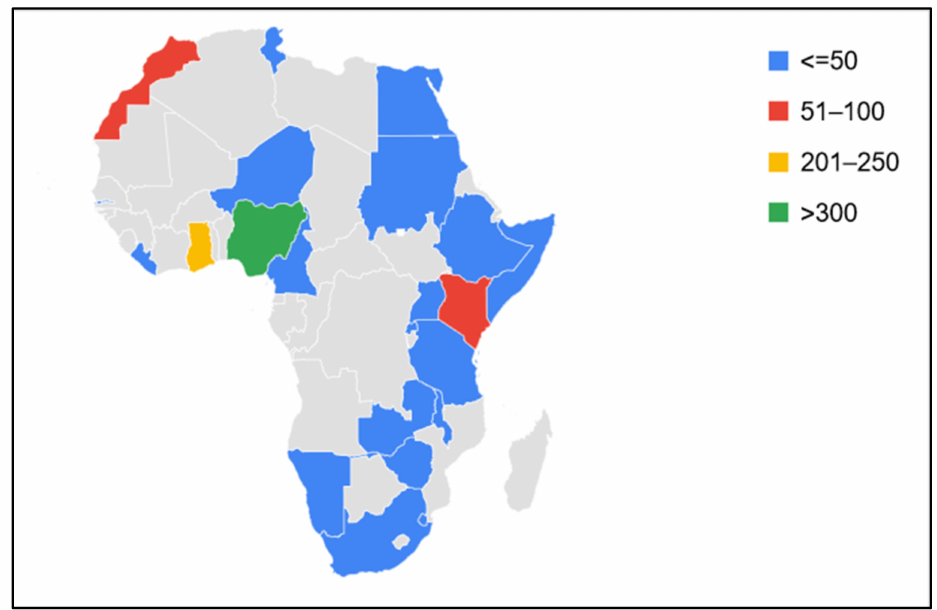
Figure 2. Distribution of respondents to questions on adverse events following COVID-19 vaccination in African countries.